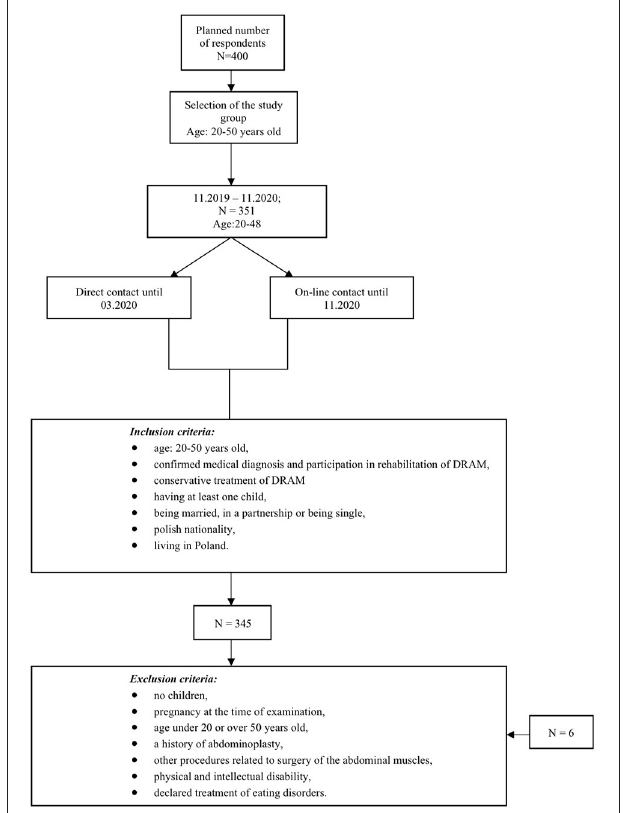
FIGURE 2 | The process of selecting respondents for the research